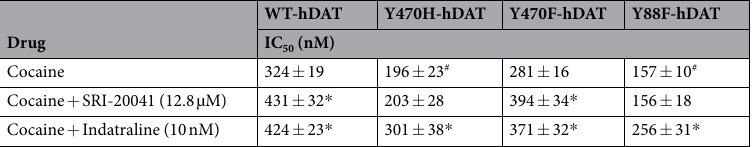
Table 1. Effects of SRI-20041 on cocaine-induced inhibition of [ 3 H]DA uptake in WT and mutated hDAT. Data are presented as mean ± S.E.M. of 5–8 independent experiments performed in duplicate. * p < 0.05 compared with the value of cocaine within WT or mutated hDAT (LSD post hoc test). # p < 0.05 compared with the value of cocaine from WT-hDAT (LSD post hoc test).